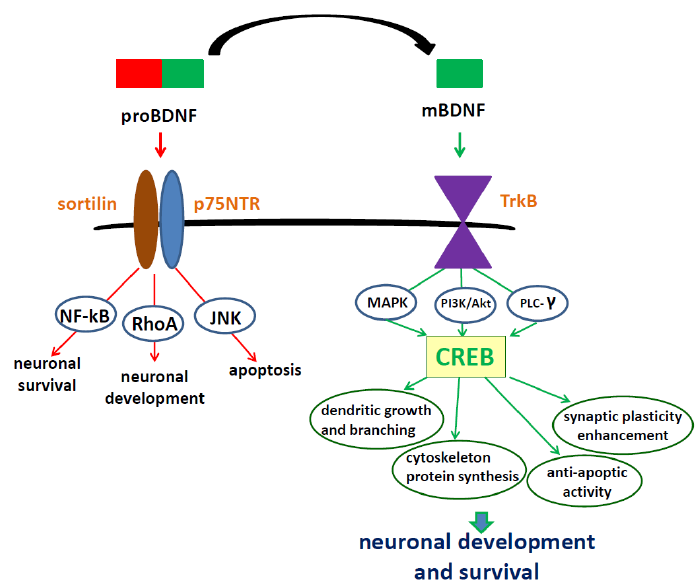
Figure 1. Signaling cascades activated by interaction of BDNF isoforms with two types of cell surface receptors, the p75 neurotrophin receptor and TrkB receptor. proBDNF has a greater affinity for the p75 receptor. The pro-BDNF/p75/sortilin complex leads to activation of JNK, RhoA, and NF-ĸB signaling pathways which promote processes such as apoptosis, neuronal growth cone development, and neuronal survival. The mBDNF/TrkB receptor complex triggers activation of three signaling pathways—MAPK, PI3K/Akt, and PLC-γ—that, in turn, activate the transcription factor CREB and transcription of genes responsible for development and survival of neurons. proBDNF— precursor of brain-derived neurotrophic factor, mBDNF—mature brain-derived neurotrophic factor, TrkB—tropomyosin receptor kinase B, JNK—c-Jun N-terminal kinases, RhoA—Ras homolog gene family member, NF-ĸB—nuclear factor kappa B, MAPK—mitogen-activated protein kinase, PI3K—phosphatidyl inositol-3 kinase, PLC-γ—phospholipase C-γ, CREB—cAMP response element-binding protein.